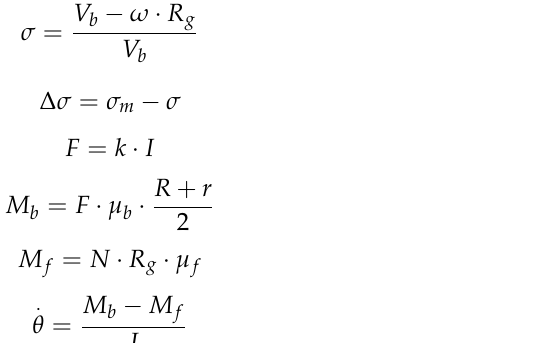
Figure 6. Brake apparatus.